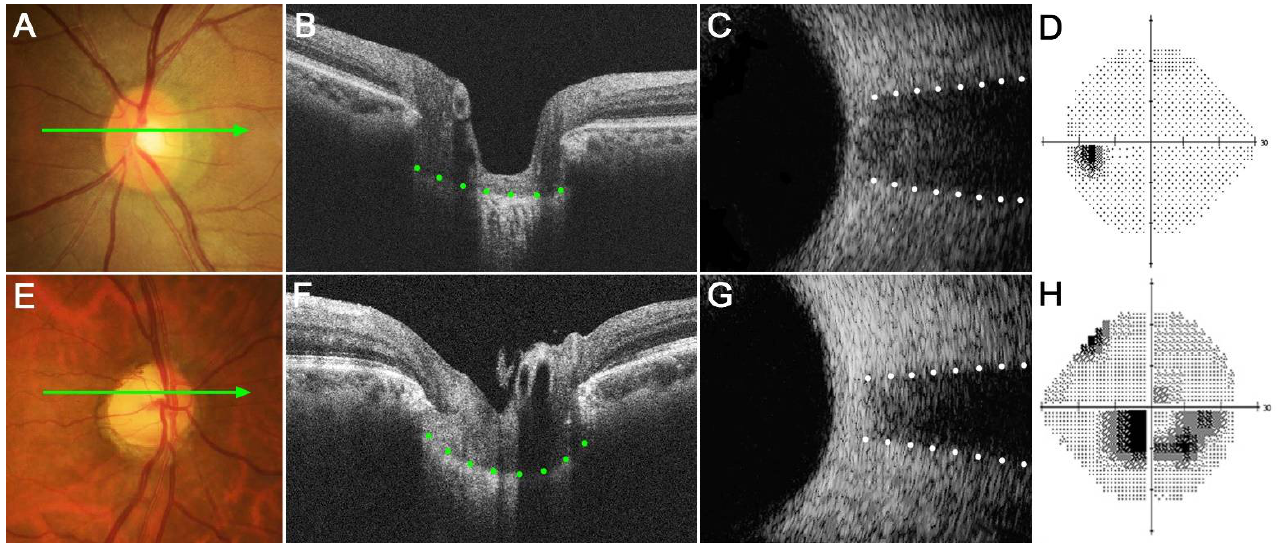
Figure 3. Representative eyes showing the relationship between the lamina cribrosa curvature index (LCCI) and optic nerve sheath diameter (ONSD). ( A – D ) A healthy left eye of a 63-year-old woman with a relatively flat LC and wide ONSD. ( E – H ) A glaucomatous right eye of a 59-year-old man with curved LC and narrow ONSD. ( A , E ) Stereoscopic optic disc photograph images. ( B , F ) Cirrus HD OCT B-scan images obtained at the locations indicated by light green arrows in ( A , E ), respectively. ( C , G ) Transorbital ultrasound images showing that ONSD was larger in the healthy eye ( C ) than in the glaucomatous eye ( G ). Note that LCCI is considerably larger in ( F ) than in ( B ), whereas the ONSD is notably larger in ( C ) than in ( G ). The comparison of these two representative eyes indicates a negative correlation between LCCI and